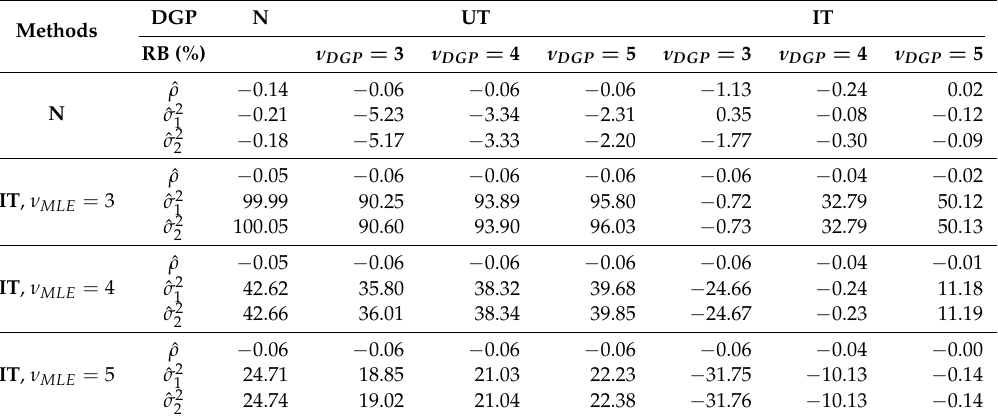
, ˆ σ 2 with ν = 2 1